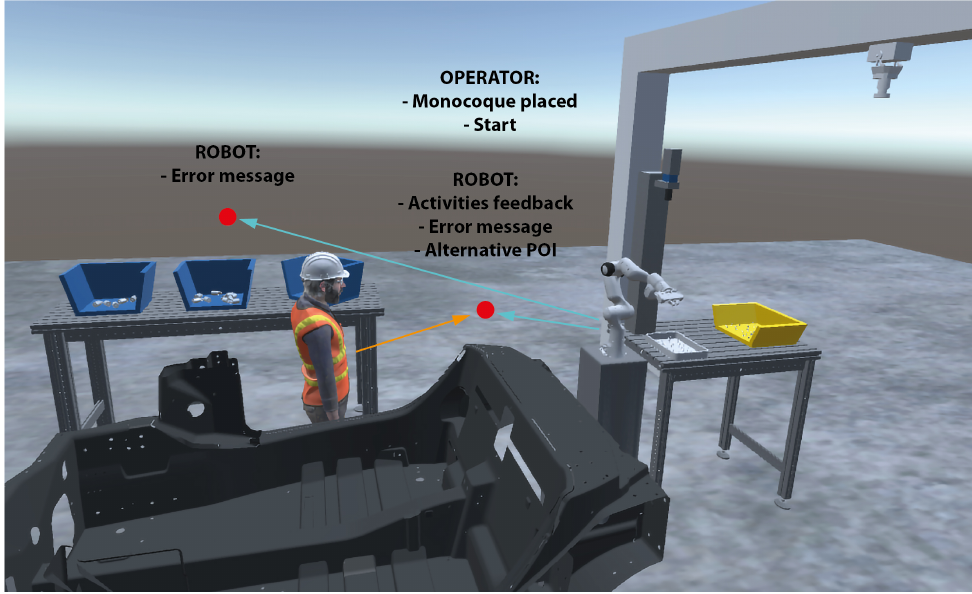
Figure 14. Human-machine interaction mapping of case